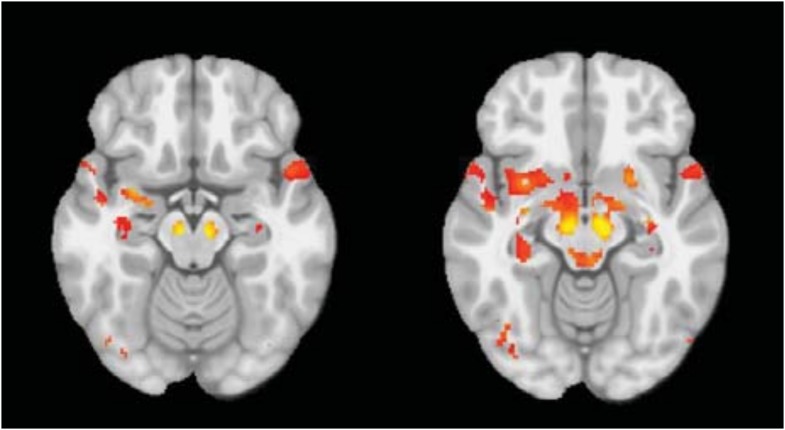
DOI:
http://dx.doi.org/10.7554/eLife.08440.026